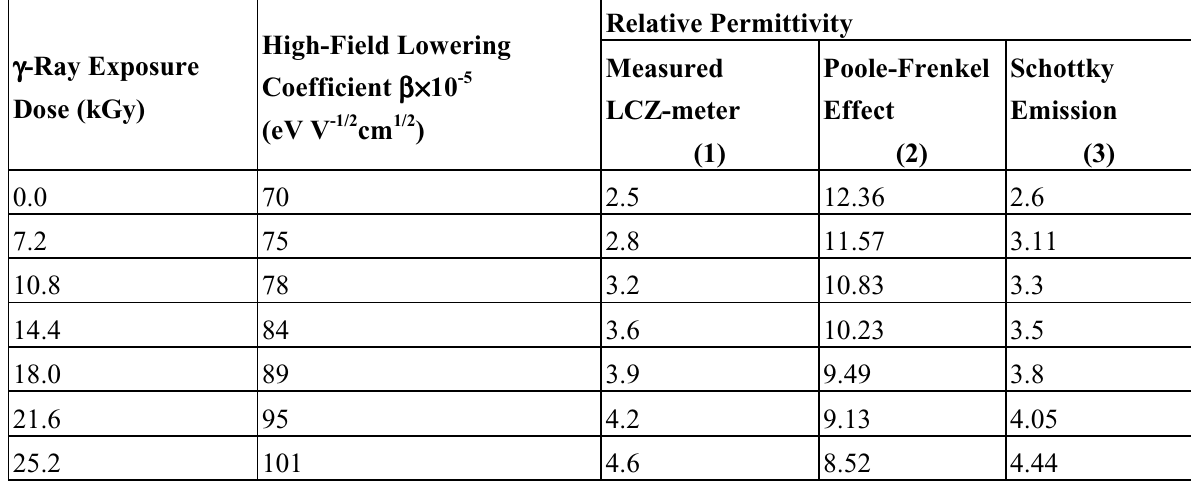
Table 1. Comparison of the measured and calculated permittivity values to reveal the type of condition